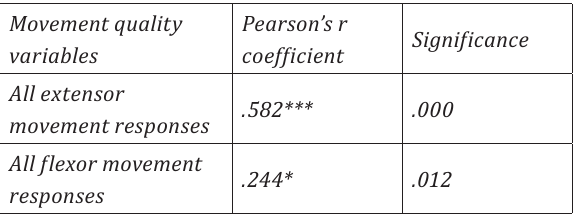
Table 6. Pearson’s r correlations between the “chiaroscuro” variable and movement quality variables in the group of all